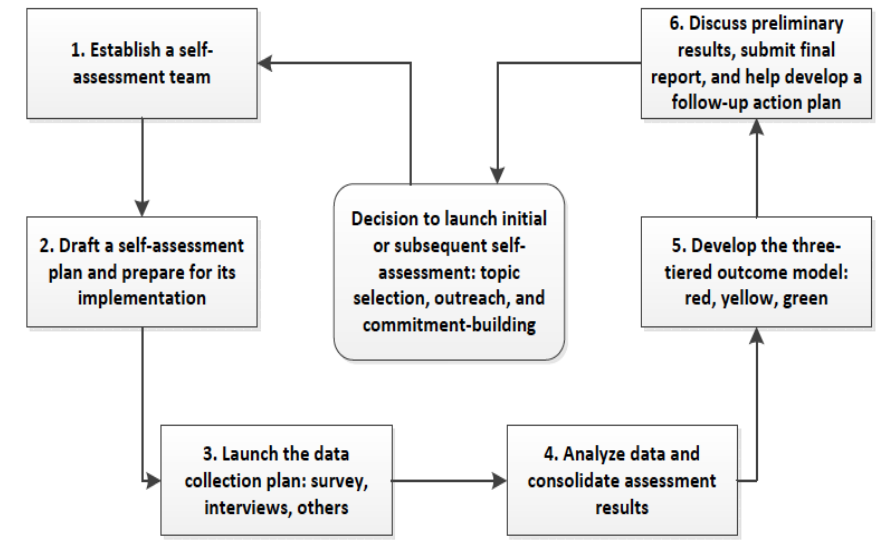
Figure 2. Multi-stage process of self-assessment of nuclear security